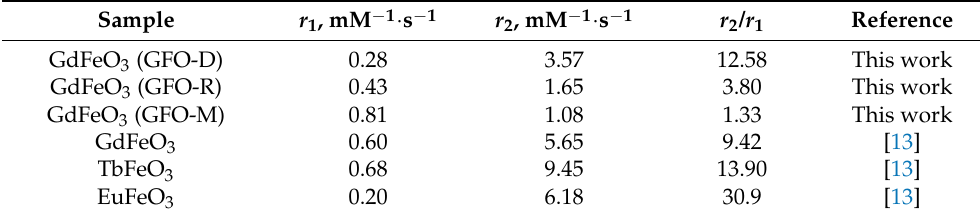
Table 4. Relaxivities of the synthesized GdFeO 3 nanocrystals, compared with literature data for other nanocrystalline rare-earth